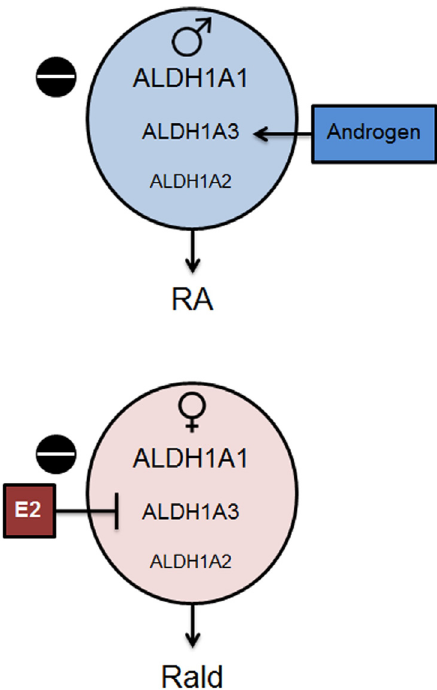
Figure 3. Schematic presentation of the sex-specific change in the retinoid balance in male and female VF. In VF of mice, Aldh1a1 was predominantly expressed compared to Aldh1a2 and Aldh1a3 (indicated by size of the letters). Aldh1a2 and Aldh1a3 levels are lower in females (pink circle) compared to those seen in males (blue circle) due to suppression of Aldh1a3 by estrogen. Deficiency in Aldh1a1 ( black circle with “ − ” symbol ) further reduces expression of Aldh1a2 and Aldh1a3 in females, which leads to decreased Rald catabolism. Rald was detected in the VF of female mice. In Aldh1a1 − / − male mice, Aldh1a3 expression is under androgen control; it can catalyze RA production from Rald in Aldh1a1 − / −